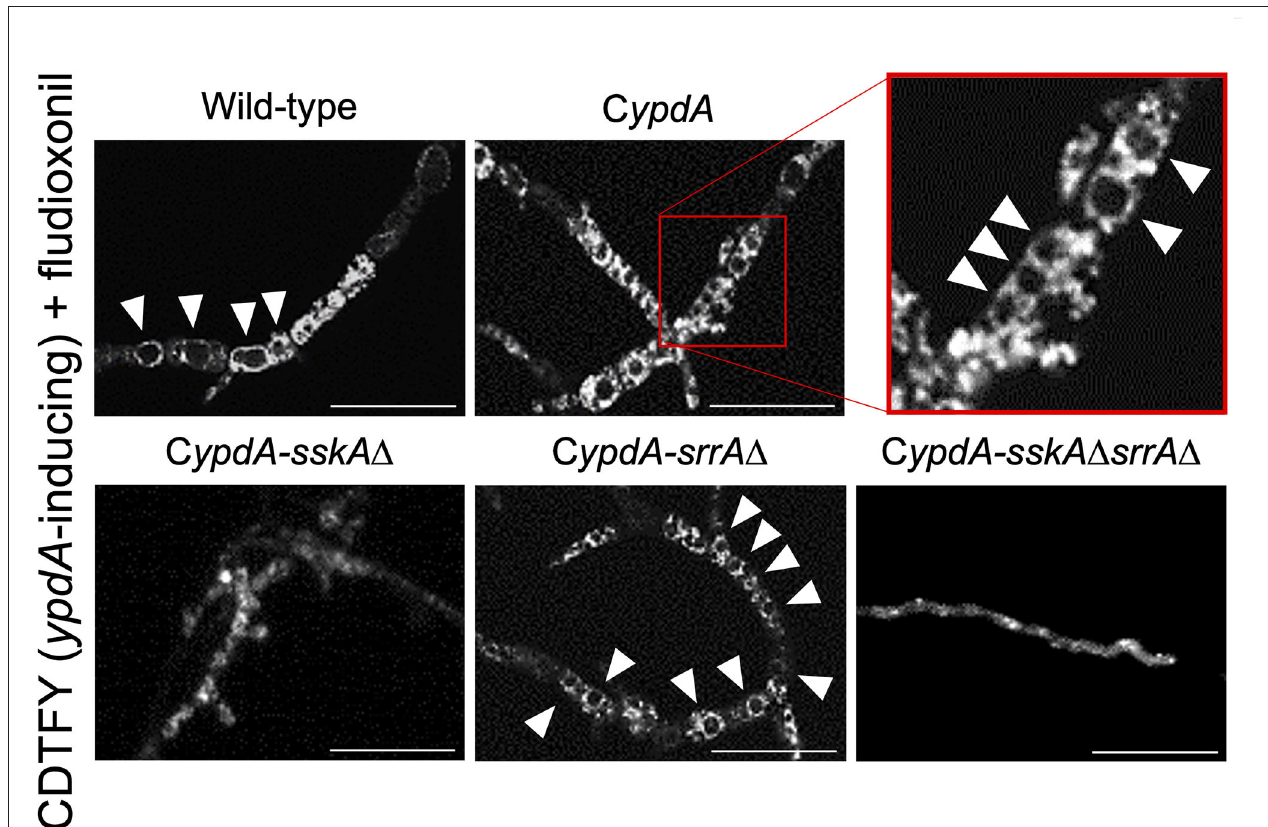
FIGURE 11 | Vacuole morphology of the wild-type and C ypdA strains treated with fludioxonil under ypdA -inducing conditions. Conidia of each strain were cultured in CDTFY ( ypdA -inducing) medium for 8h at 37 ◦ C, then transferred to CDTFY with 0.1 µ g/ml fludioxonil and incubated for 4h at 37 ◦ C. After incubation, mycelia were stained with FM4-64 and vacuoles were observed by fluorescence microscopy. Arrowheads indicate vacuoles. Bars, 35 µ m.